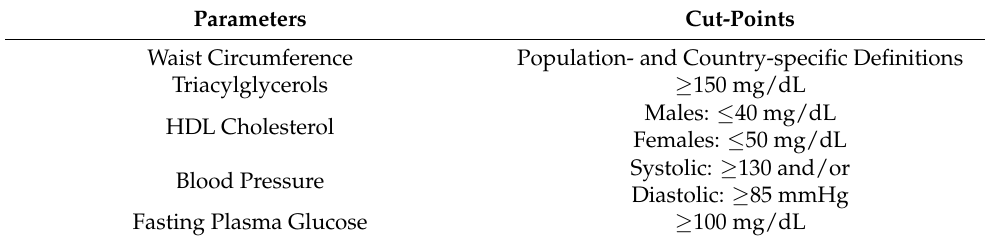
Table 1. Criteria for clinical diagnosis of metabolic syndrome (MetS)